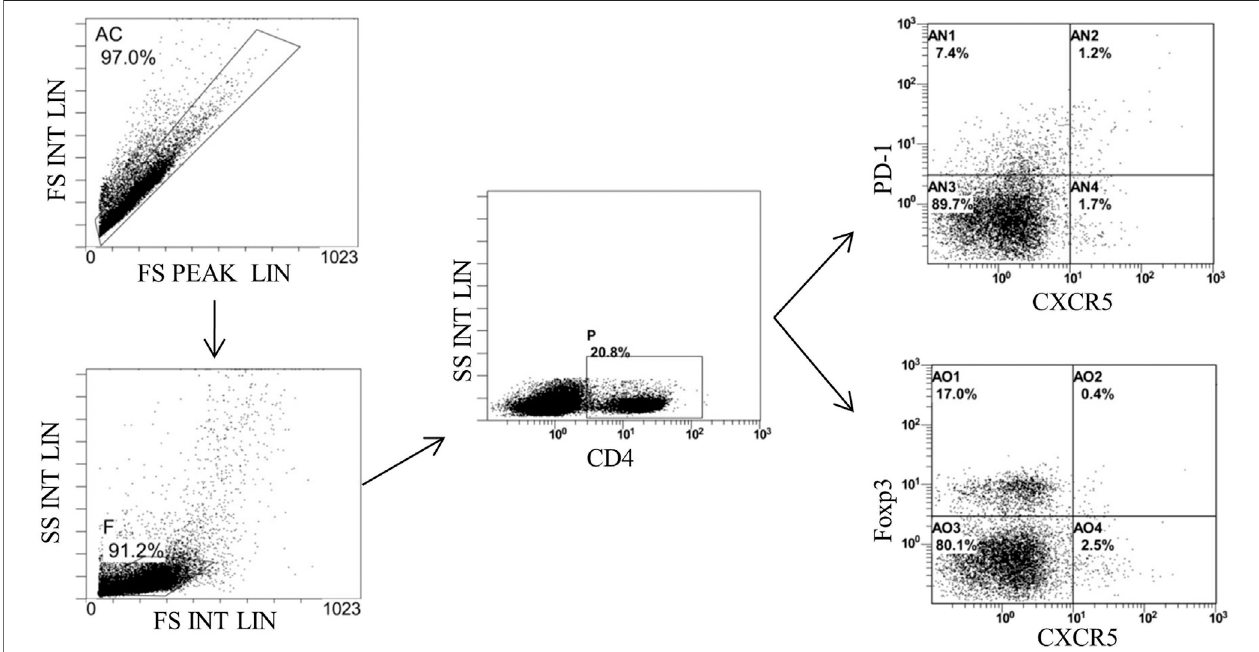
FIGURE10| Gating strategyofTfhand Tfrin thespleenofmice detected by fl owcytometry. Gate AC:nonadherent cells; gateF: lymphocytes;gate P:CD4 + cells: gate AN2: CD4 + CXCR5 + PD-1* Tth in CD4 + cells; and gate AO2: CD4 + CXCR5 + Foxp3 + Tfr in CD4 + cells.